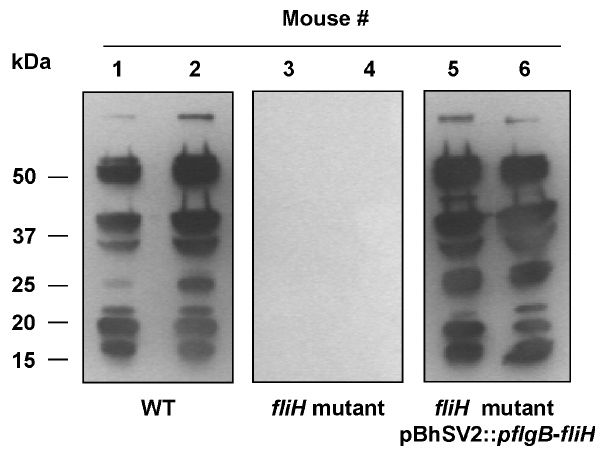
Figure 9. Mice inoculated with fliH mutant do not seroconvert to B. hermsii . Serum samples were examined by immunoblot for antibodies to wild-type B. hermsii in mice 8 weeks after inoculation with wild-type (WT) B. hermsii (Mice # 1 and # 2), the fliH mutant (Mice # 3 and # 4), and the fliH mutant complemented with pBhSV2:: pflgB - fliH (Mice # 5 and # 6). Representative results are shown for two of the four mice in each group and demonstrate the complete lack of antibody detectable in the mutant-infected mice. Molecular mass standards are shown on the left in kDa.